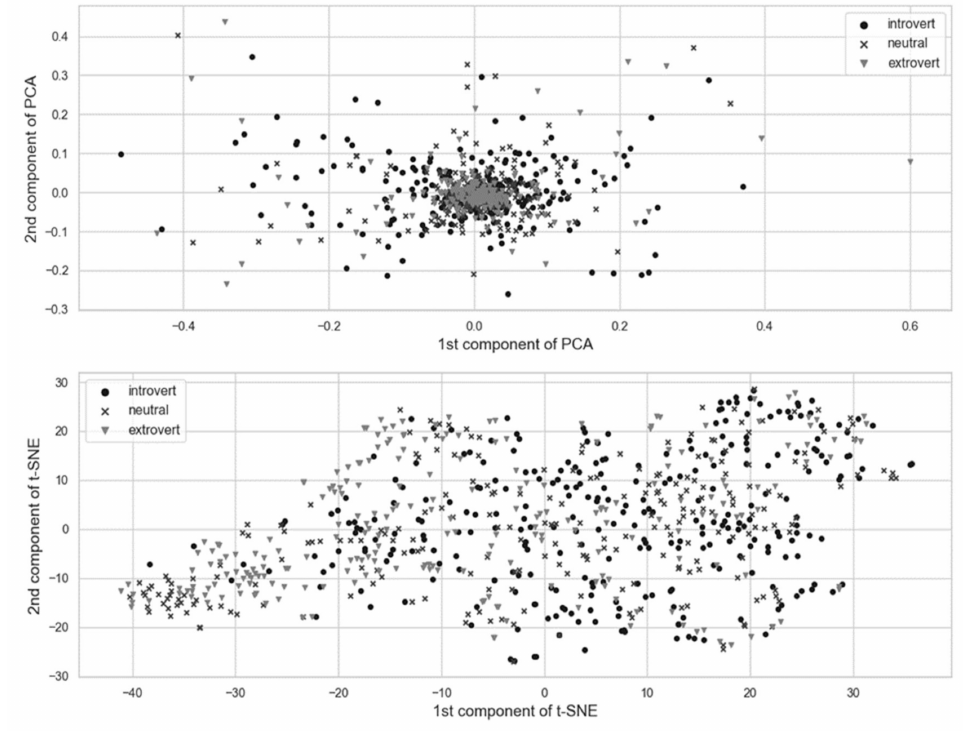
Figure10. Visualizationofthelatentspacegeneratedbythe45-dimensionalparameterizationemploying parameters calculated by the MIRtoolbox